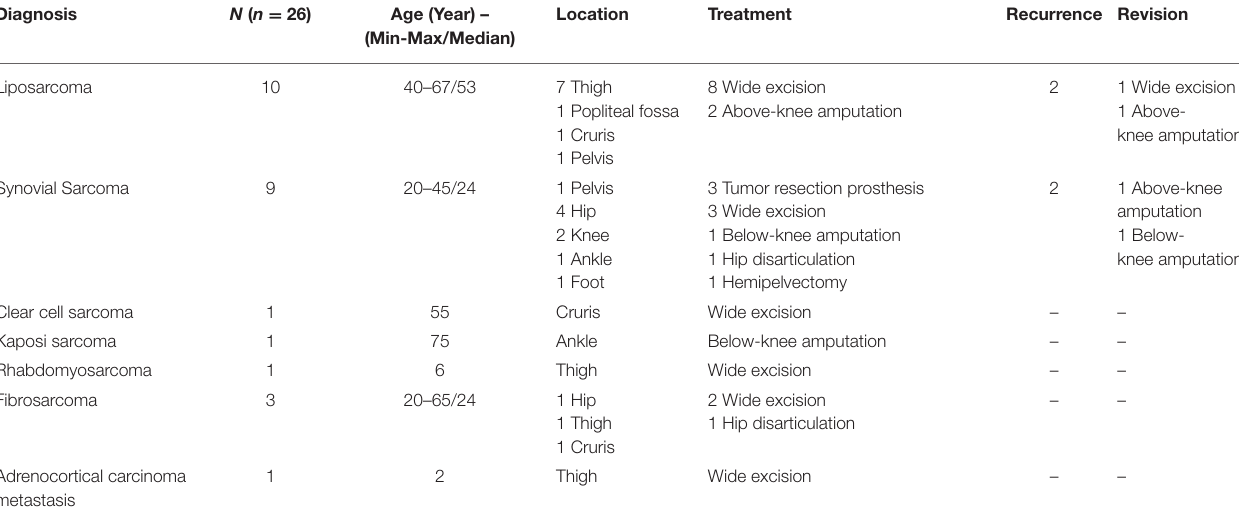
TABLE 7 | Malignant soft tissue tumors of the lower extremity.